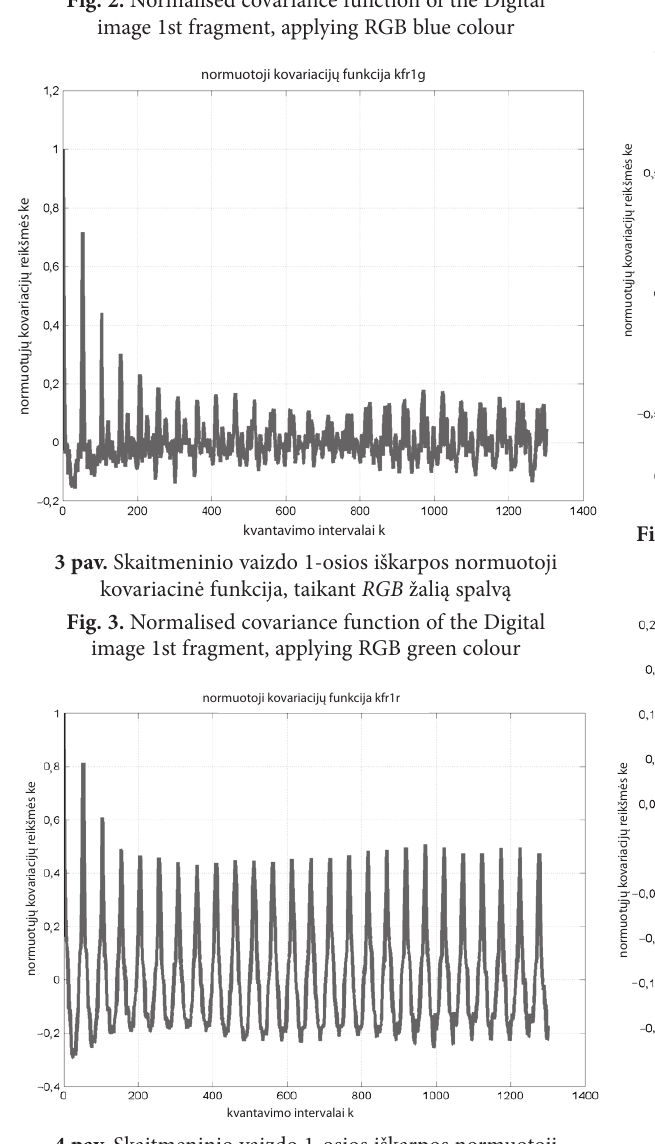
kovariacinė funkcija, taikant RGB visų spalvų tenzorių Fig. 5. Normalised covariance function of the Digital image 1st fragment, applying RGB tenzor of all colours